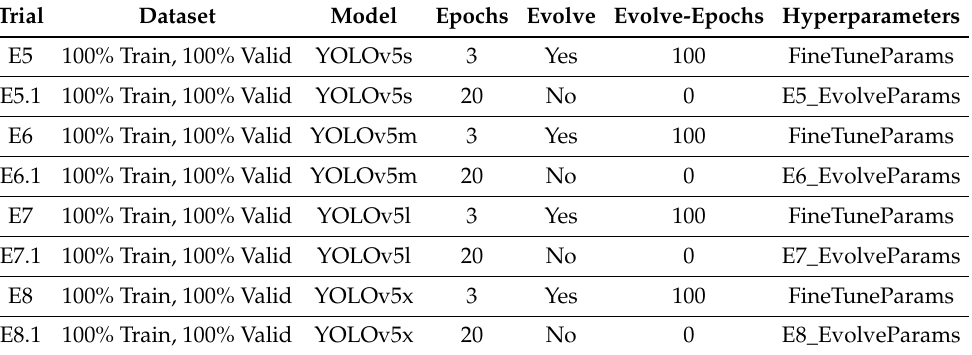
Table 10. Tests performed for four object detection algorithms selected for masks and glasses detection task using thermographic